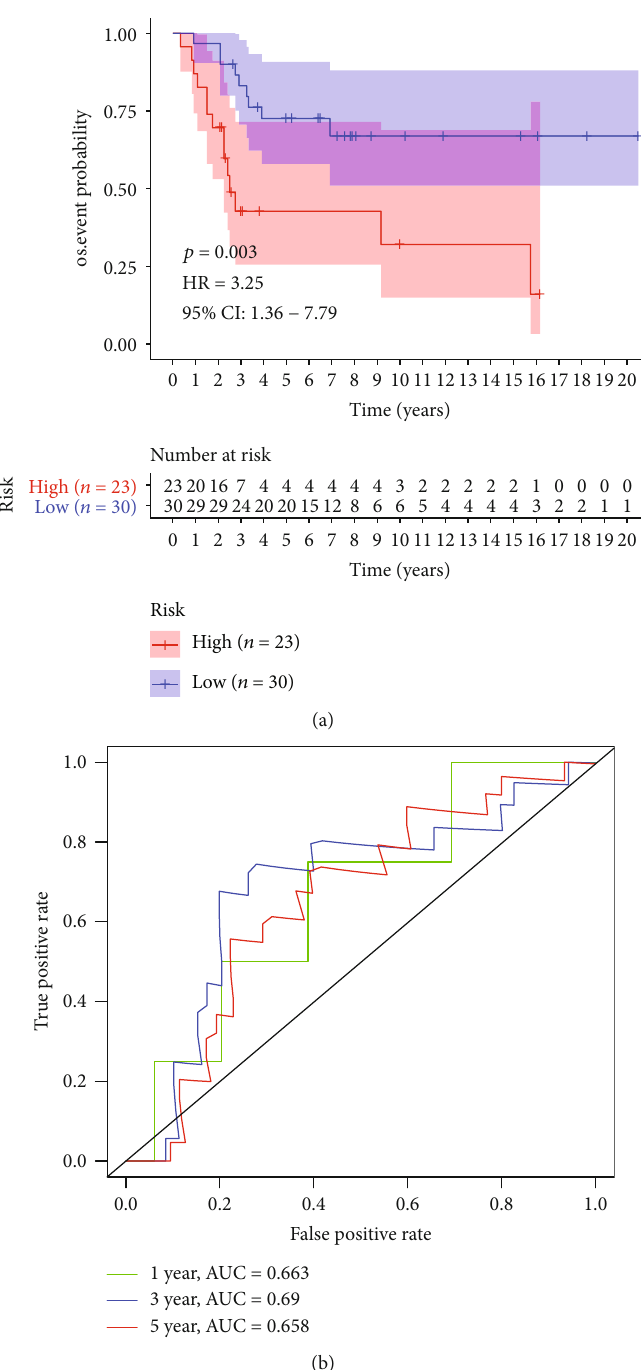
Figure 5: The results of evaluating the accuracy of the EVI2B model. (a) Survival analysis between high- and low-risk groups in GSE21257. (b) The result for the ROC curve of the GSE21257